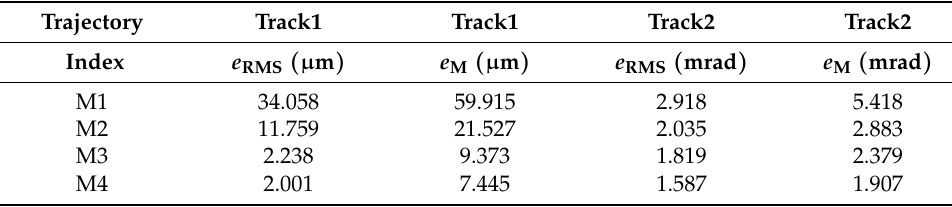
Figure 7. Tracking results of Track2 with complex disturbance. ( a ) Tracking error in s γ -axis. ( b ) Disturbance quantity and its estimated value. ( c ) Convergence rate of e RMS in s γ -axis. Table 2. Tracking performance of the MLRT with complex